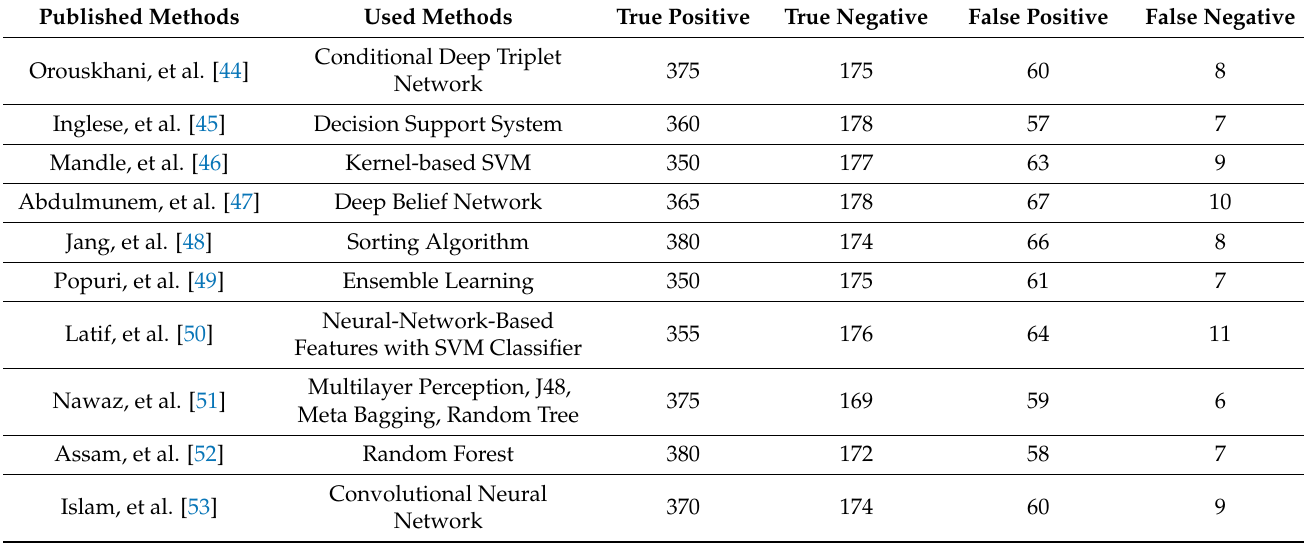
Table 10. Performance comparison of the state-of-the-art methods and the proposed approach using various evaluation measurements on brain MRI dataset (Number of utilized images 595 (where, normal = 115, and abnormal =